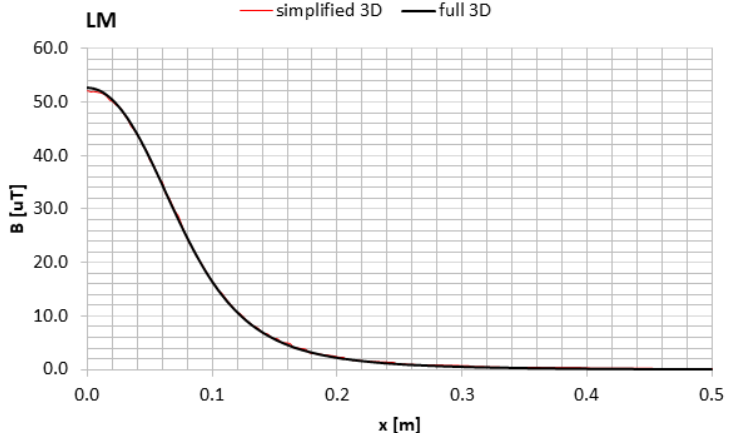
Figure 5. Magnetic induction field comparison between full 3D model and simplified model in between the two coils.